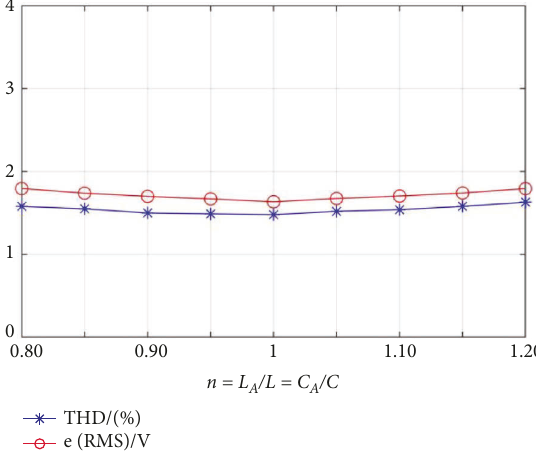
c ( s ) with a variation of n .